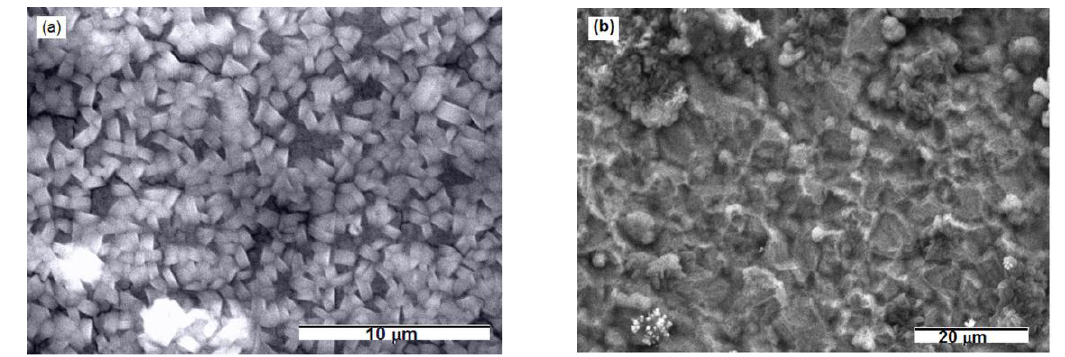
Figure 2. Scanning electron microscopy (SEM) micrographs of Au substrate after Mg electrodeposition by using potentiostatic techniques from: ( a ) magnesium/ammonium nitrate eutectic mixture melt at 400 K and ( b ) nonaqueous magnesium/ammonium nitrate eutectic mixture melt at 460 K.